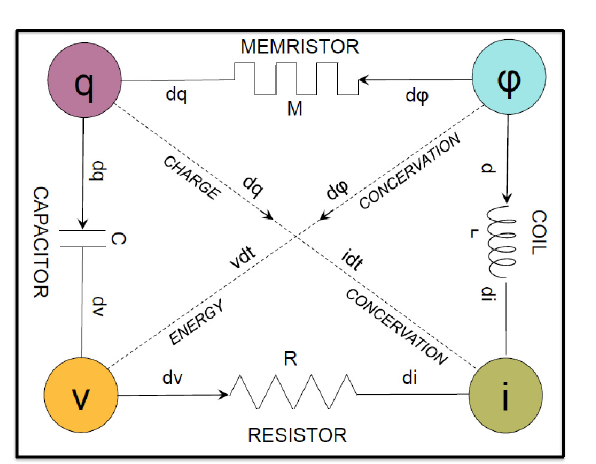
Fig. 2: Symmetry diagram showing the 6 distinct possible realizations based on the four circuit variables. Courtesy of C. Lütken [4].